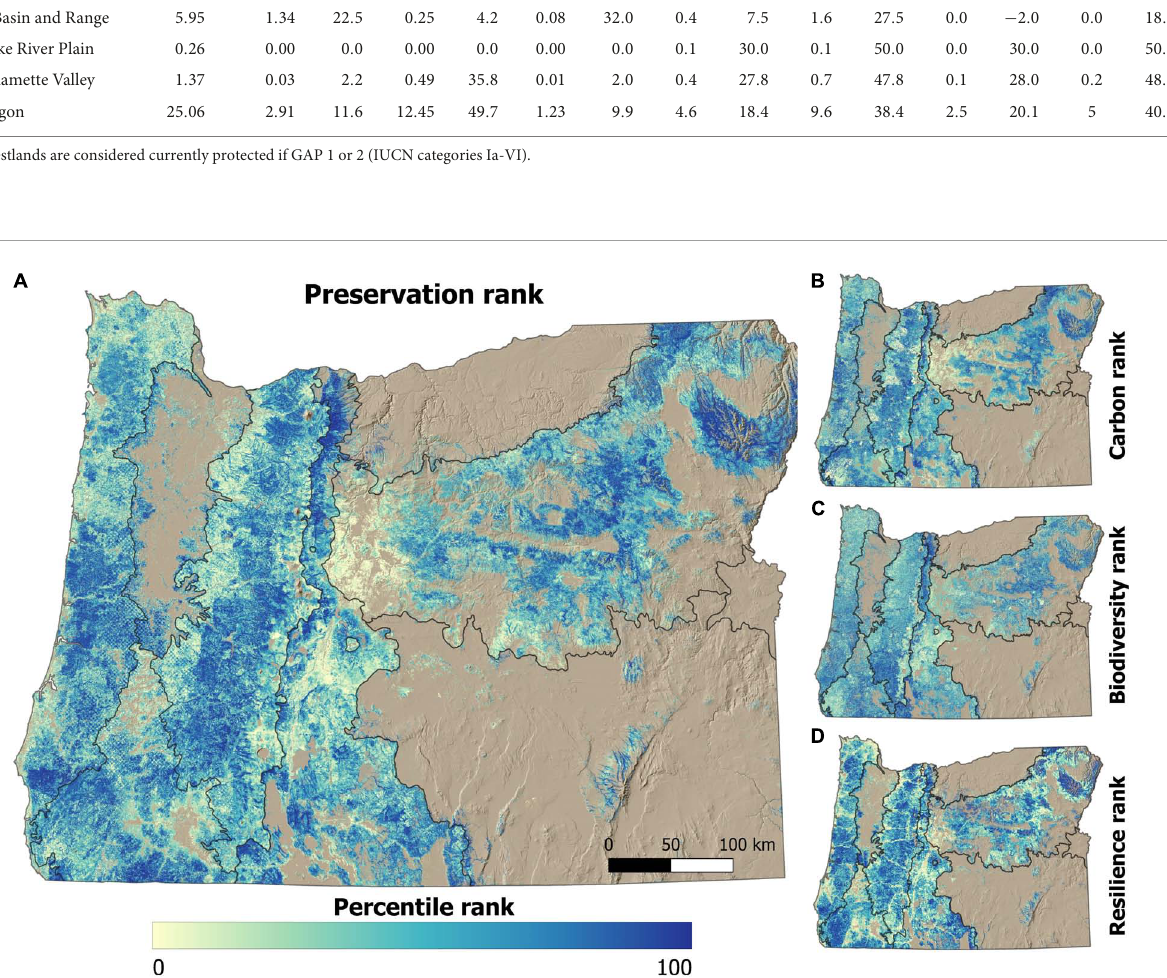
Frontiers in Forests and Global